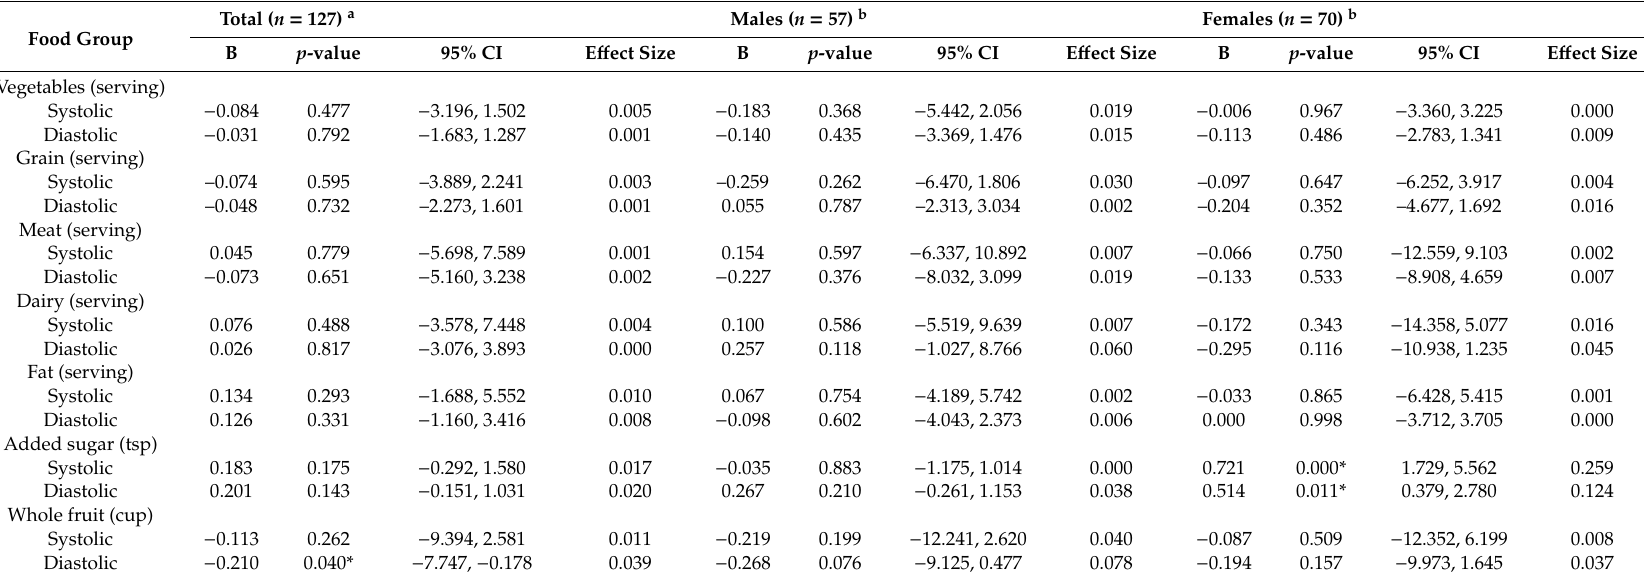
Table 3. Regression analysis of associations among food groups and systolic and diastolic blood